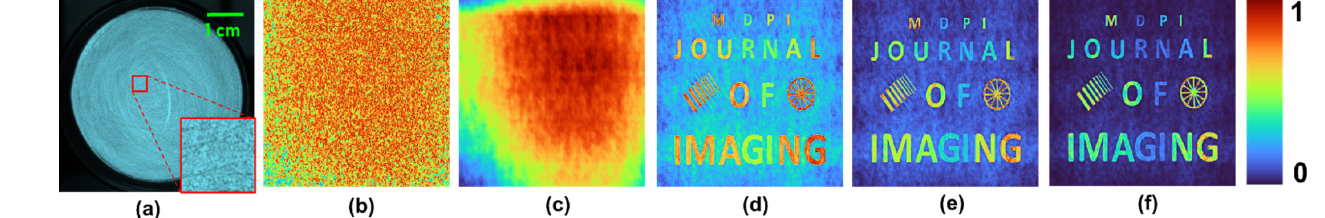
Figure 8. ( a ) Image of the QRL fabricated using lens grinding with sandpaper. ( b ) Recorded PSF, ( c ) object’s response pattern. Reconstruction results using ( d ) NLR ( p = 1), ( e ) NLR ( p = 2) and ( f ) NLR ( p = 3).